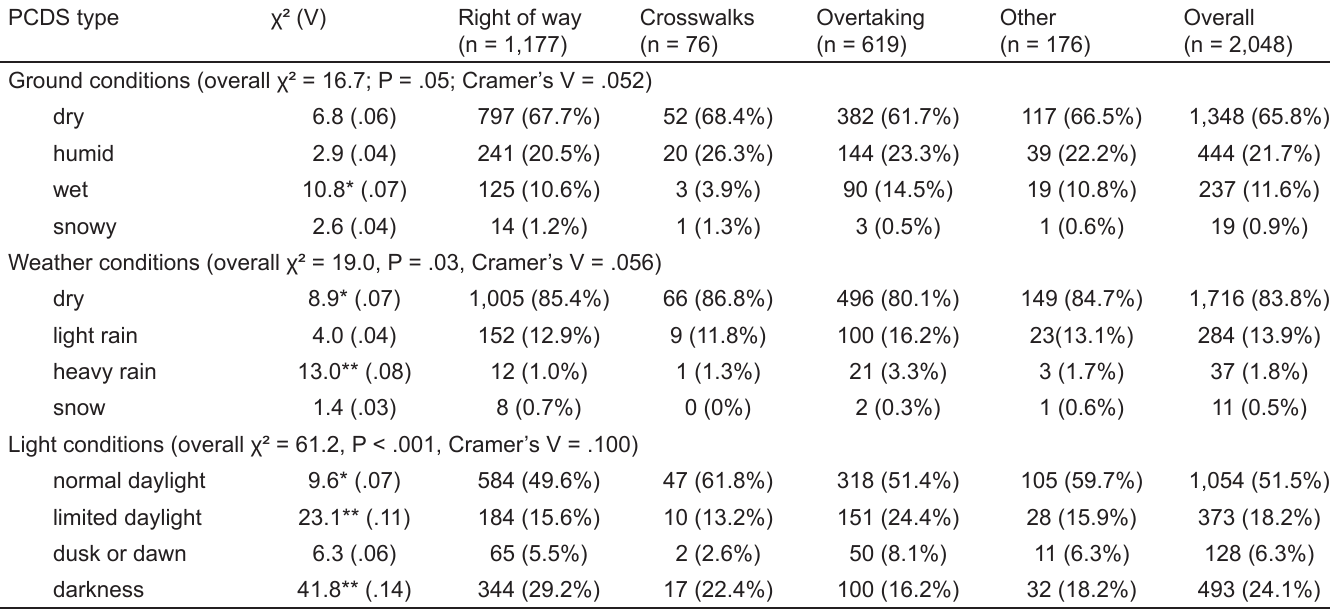
Table 3. Environmental ground, weather and light conditions for all incident types (unit of analysis: potentially critical driving